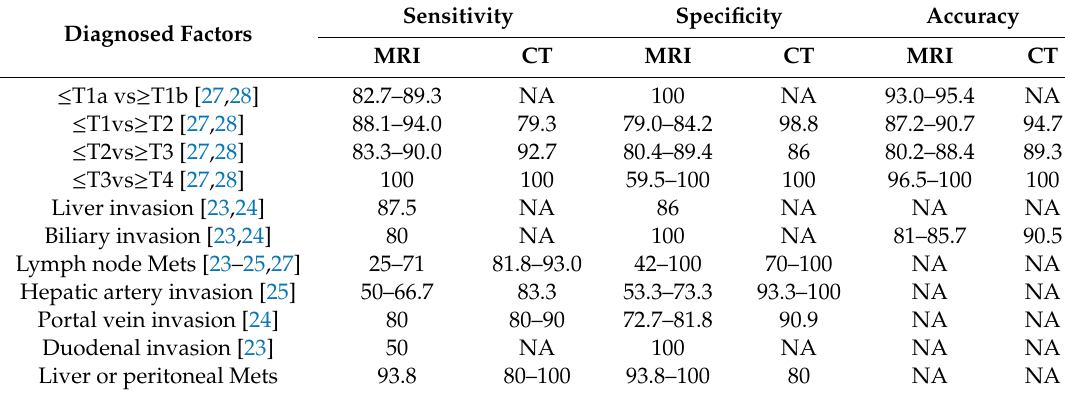
Table 5. Reported sensitivity, specificity, and accuracy of diagnosis in patients with gallbladder